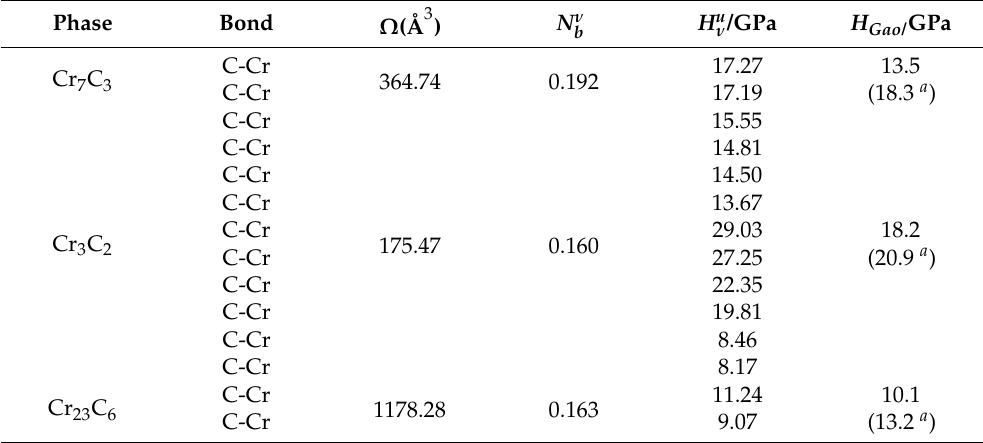
), the hardness of u b